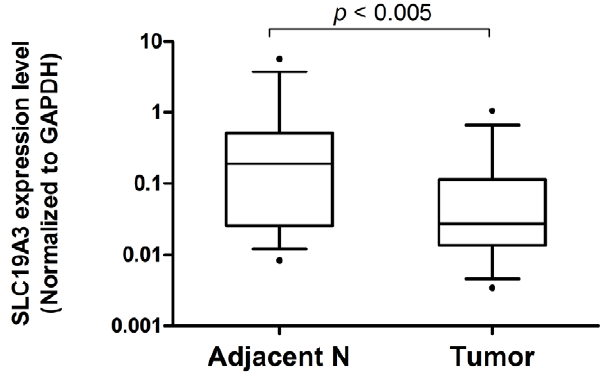
Figure 1. Down-regulated SLC19A3 gene expression in primary breast cancer tissues. Relative SLC19A3 mRNA expression between tumor tissues and their paired adjacent non-tumor breast from breast cancer patients (n=15) by real-time qPCR. Expression of SLC19A3 mRNA (Log 10 scale at Y-axis) was normalized to GAPDH. The lines inside the boxes denote the medians. The boxes mark the interval between the 25 th and 75 th percentiles. The whiskers denote the interval between the 10 th and 90 th percentiles. Statistical difference was analyzed by Wilcoxon test, P , 0.005.